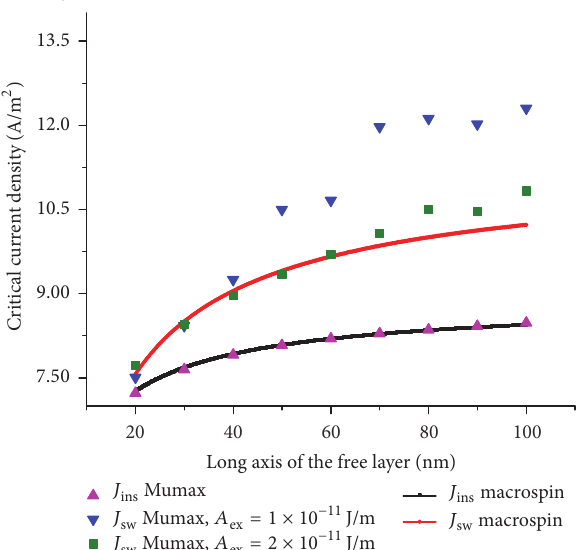
Figure 3: 𝐽 and 𝐽 dependence on long axis length of the free ins sw layer with 𝑡 𝑓 = 1.5 nm and 𝜆 = 2. Intermediate current density leads to stable oscillation of m .